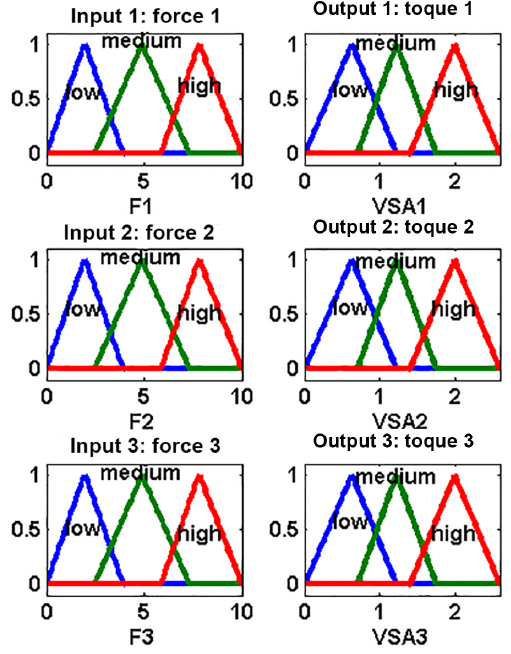
Figure 15. Fuzzy sets of inputs and outputs.